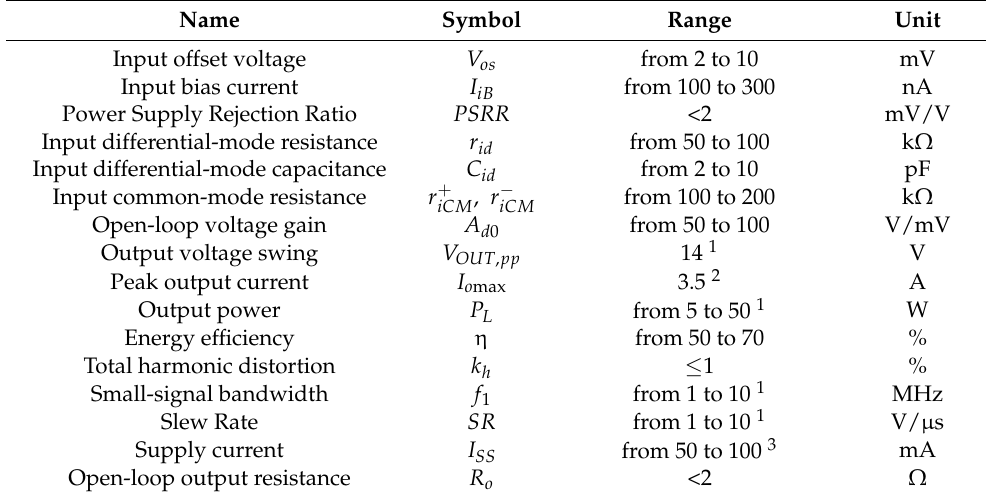
Table 1. Basic DC and AC electrical parameters for the monolithic amplifiers from